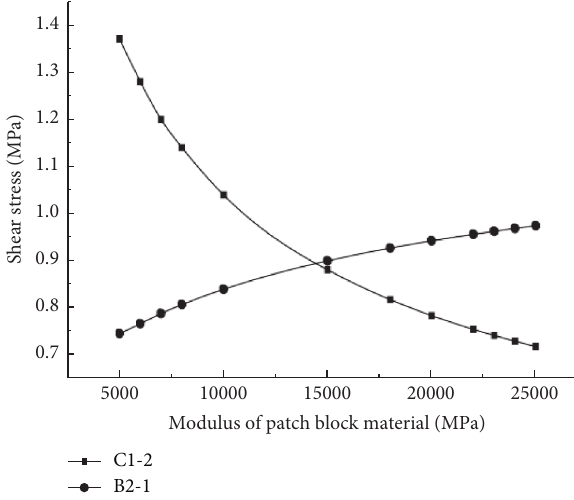
Figure 14: The effect of patch material modulus on shear stress of joint filling materials.